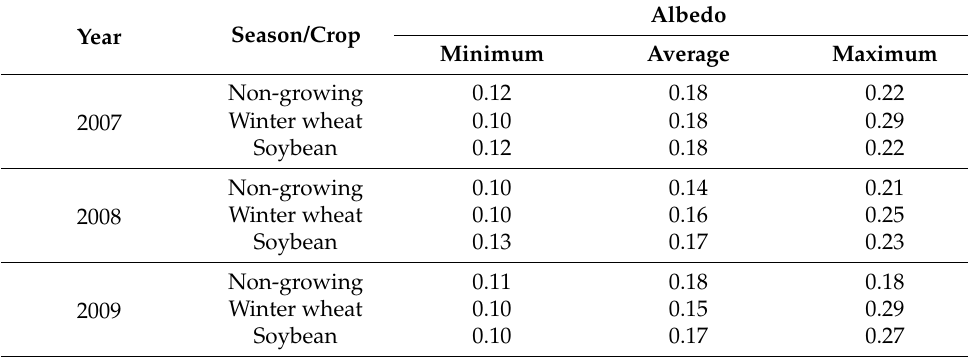
Table 2. Seasonal minimum, average, and maximum albedo